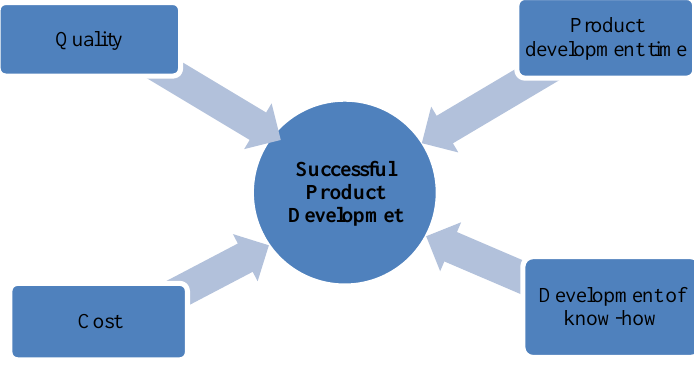
Figure 1. Successful of product